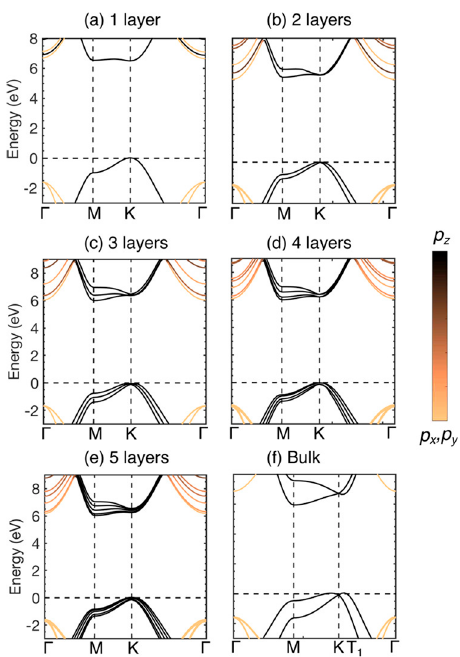
Figure 3. Evaluated bandgap structure of hBN with ( a ) one, ( b ) two, ( c ) three, ( d ) four, and ( e ) five layers, and ( f ) bulk hBN. Figures are adapted with permission from [24]. Copyright 2018 American Chemical Society.